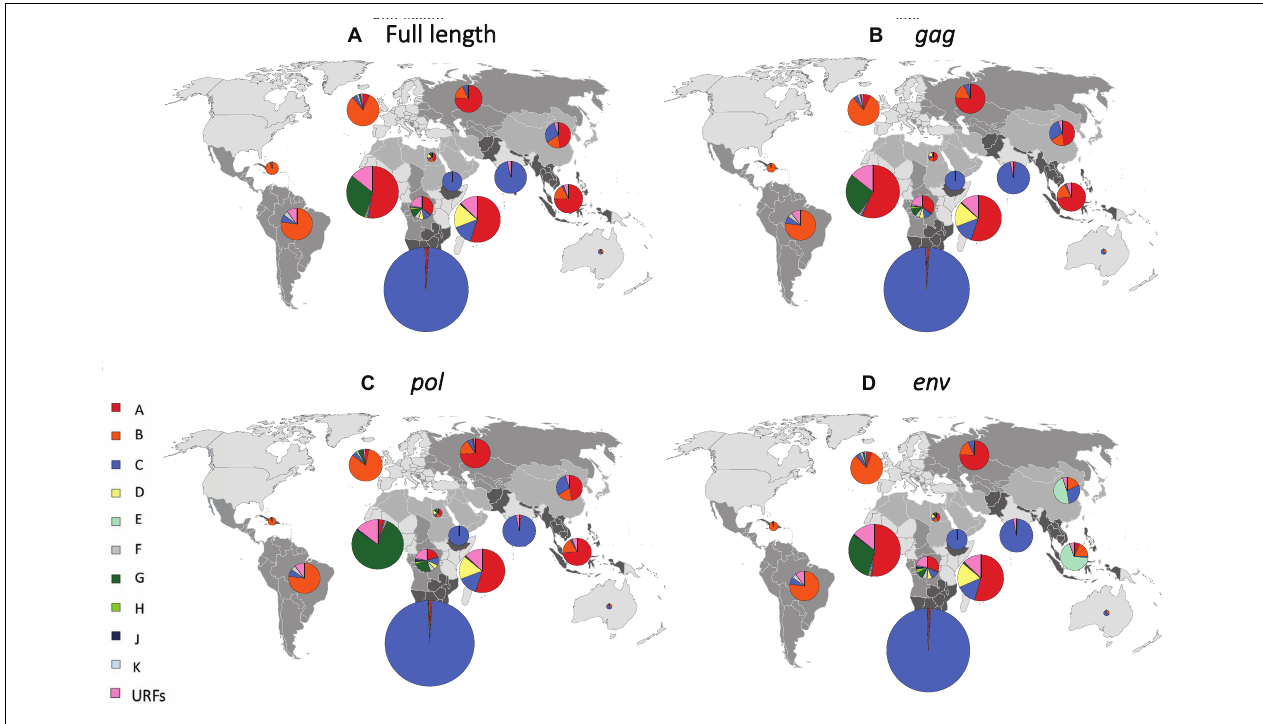
FIGURE 2 | Regional distribution of HIV-1 subtypes after reassignment of CRFs to “pure” HIV-1 subtypes. Regional proportions of HIV-1 subtypes after reassignment of CRFs to “pure” HIV-1 subtypes, based on full-length sequence (A) , gag (B) , pol (C) , and env (D) . We grouped all countries into 14 regions, as previously described (Hemelaar et al., 2019). Individual regions are shaded differently on the world map. The proportion of HIV infections attributed to each subtype in each region is shown in pie charts superimposed onto the regions. The sizes (surface area) of the pie charts for each region are proportional to the relative number of people living with HIV in each region. URF, unique recombinant form. Data underlying this figure is displayed in Supplementary Material , pp.